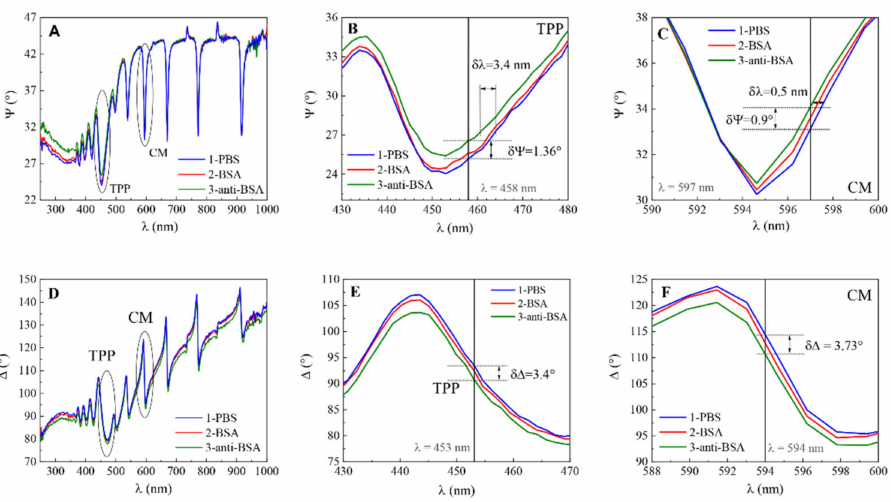
Figure 6. Spectra of ellipsometric parameters Ψ vs. λ for ( A ): 1-PBS, 2-BSA, 3-anti-BSA, ( B , C ) zoomed view and ∆ vs. λ for ( D ): 1-PBS, 2-BSA, 3-anti-BSA, ( E , F ) zoomed